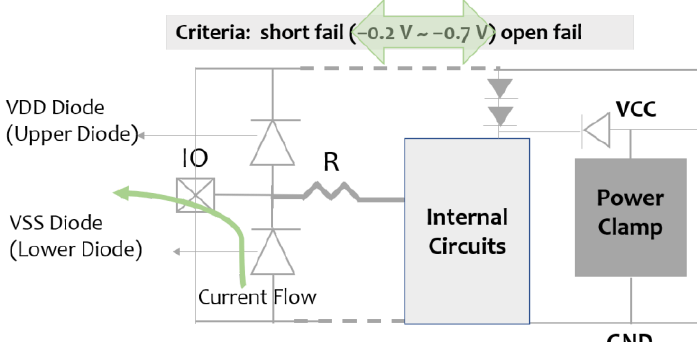
Figure 6. The test criteria and methodology of the open/short test.